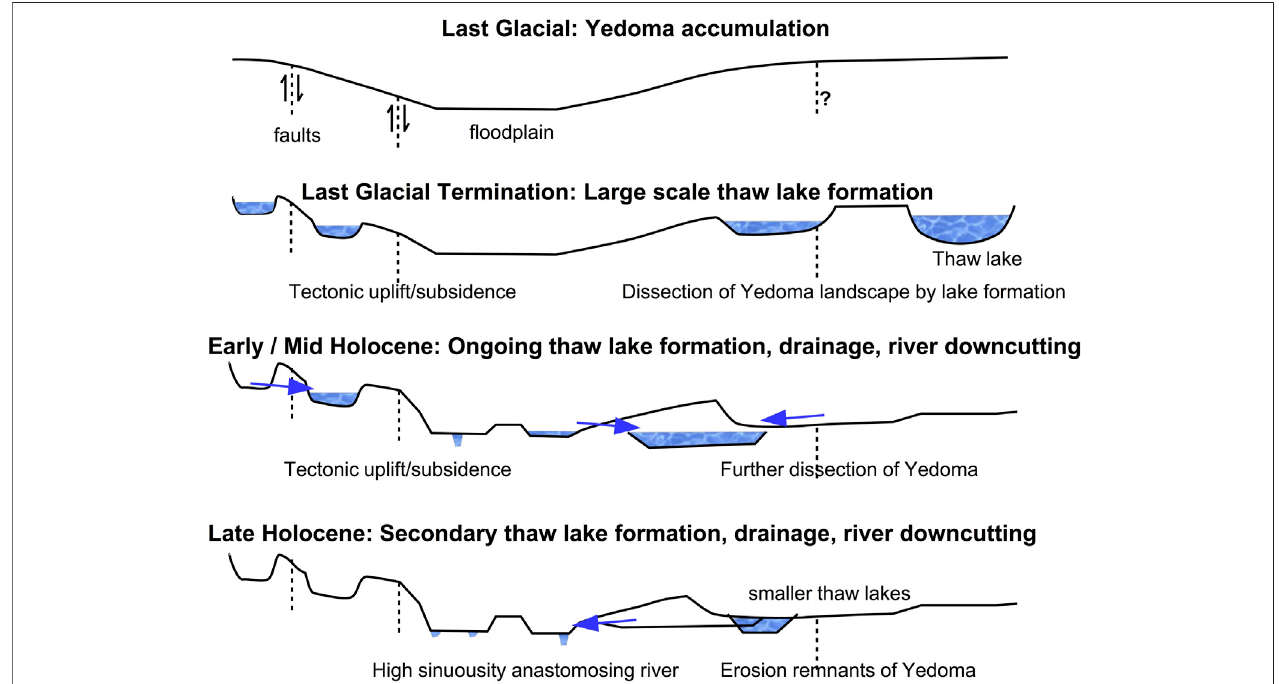
FIGURE 12 | Schematic summary of the Late Glacial and Holocene landscape development along a hypothetical North-South topographical pro fi le across the study area.